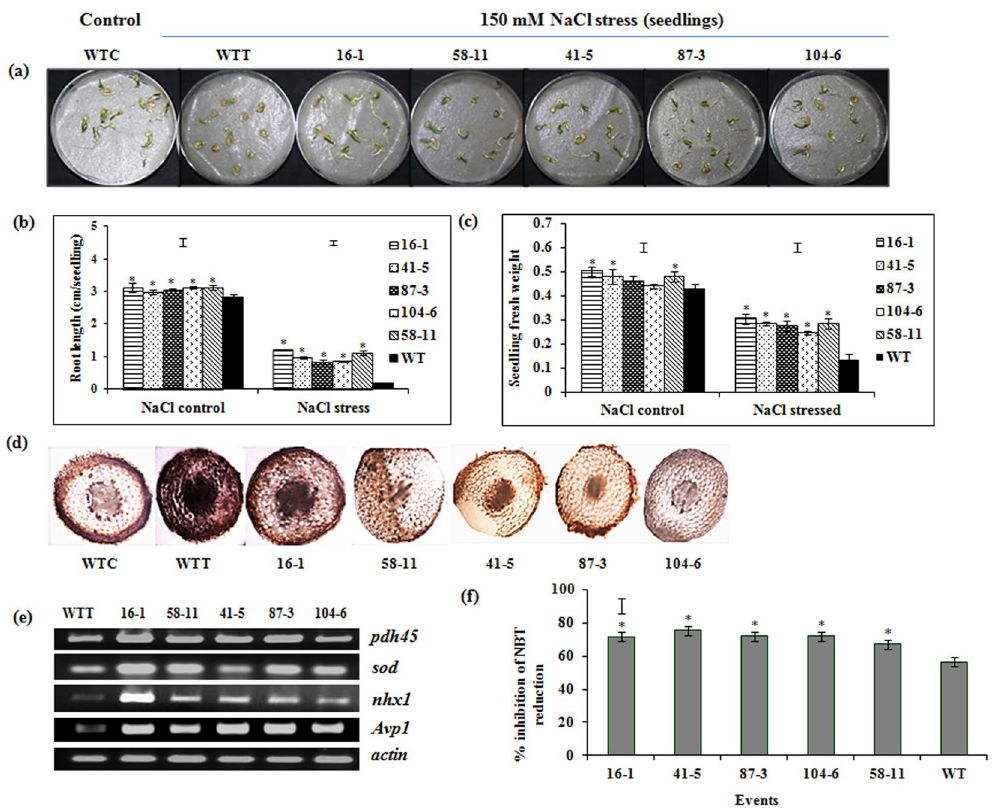
Figure 4. Response of the selected transgenic events to simulated salt stress. ( a ) Effect of salt stress (150 mM NaCl) on the seedlings of transgenic events and WT; ( b ) seedling root length (cm); ( c ) seedling fresh weight (g); ( d ) cross sections of roots stained with DAB; ( e ) sqRT-PCR analysis of PDH45 and stress-responsive genes in the stressed seedlings; ( f ) SOD activity in terms of percent inhibition of NBT reduction in the seedlings of WT and transgenic events treated with 150 mM NaCl. (WTC = wild type control; WTT = wild type treated. Bars in the graph area indicate LSD value at P < 0.05; ( * ) indicates significant differences at P <